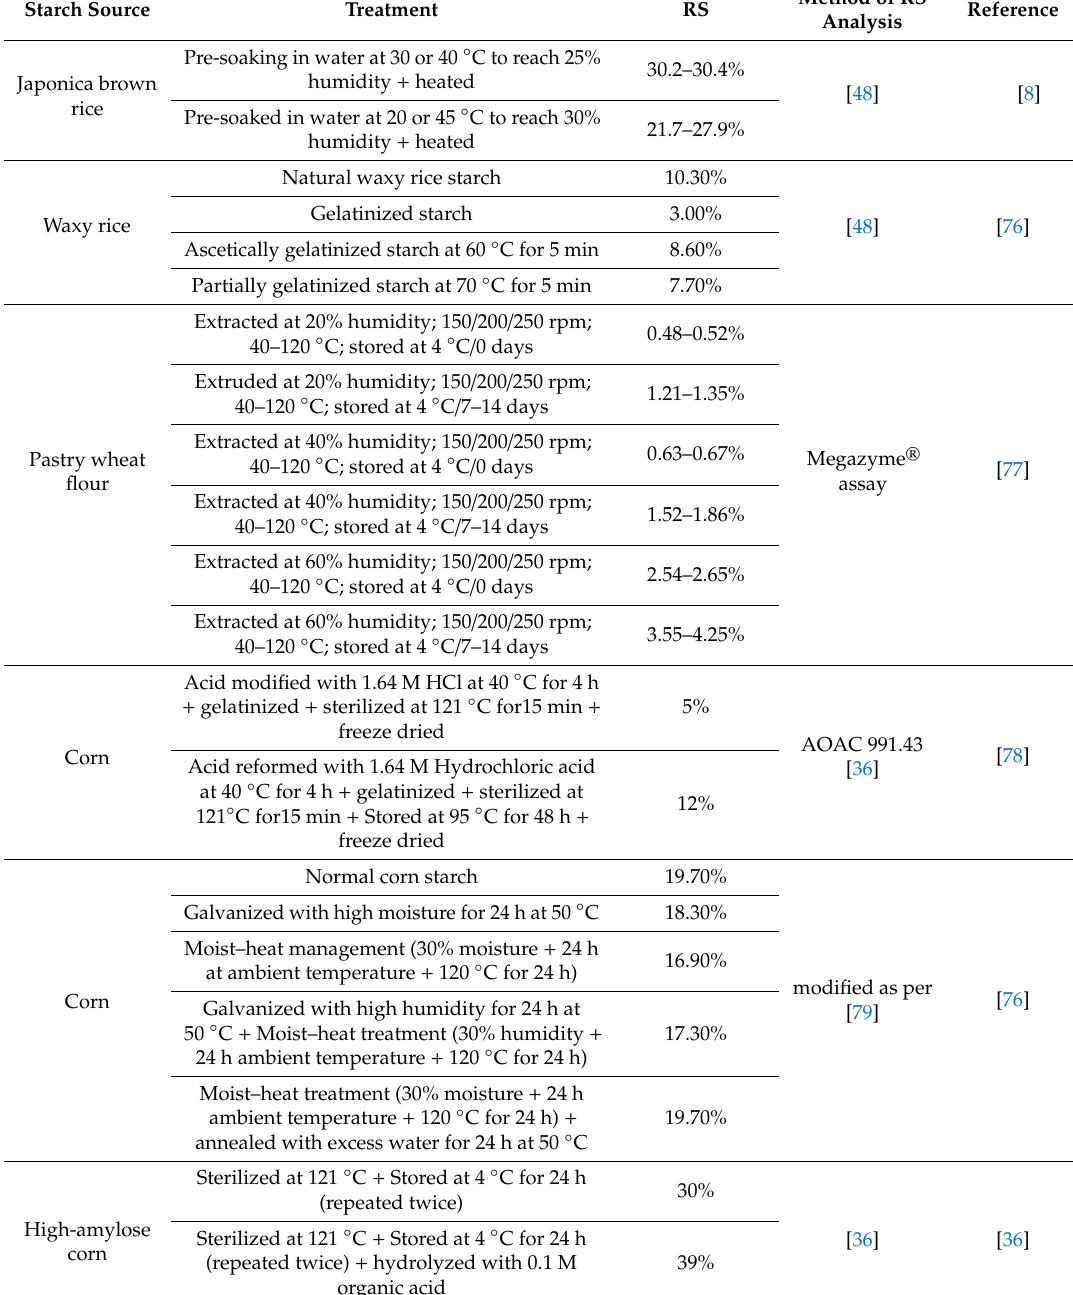
Table 4. Resistant starch level in cereal starches after